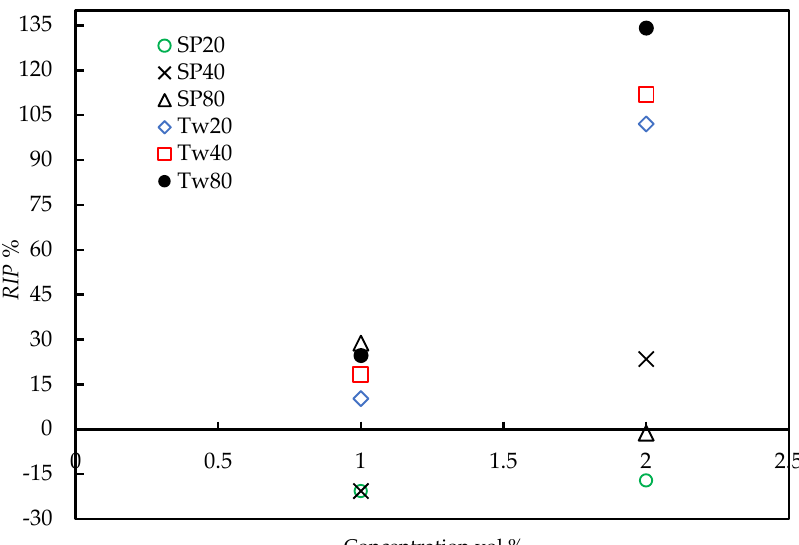
Figure 6. Relative inhibition power of nonionic surfactants in multi-phase system (Oil/H 2 O: 50/50; 277 K, 8.50 MPa).